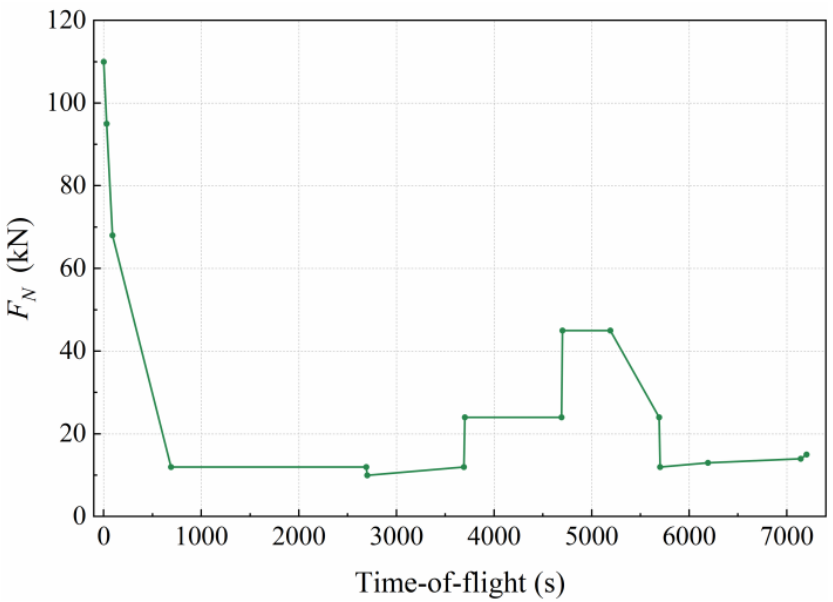
Figure 2. The required thrust profile of a flight mission.